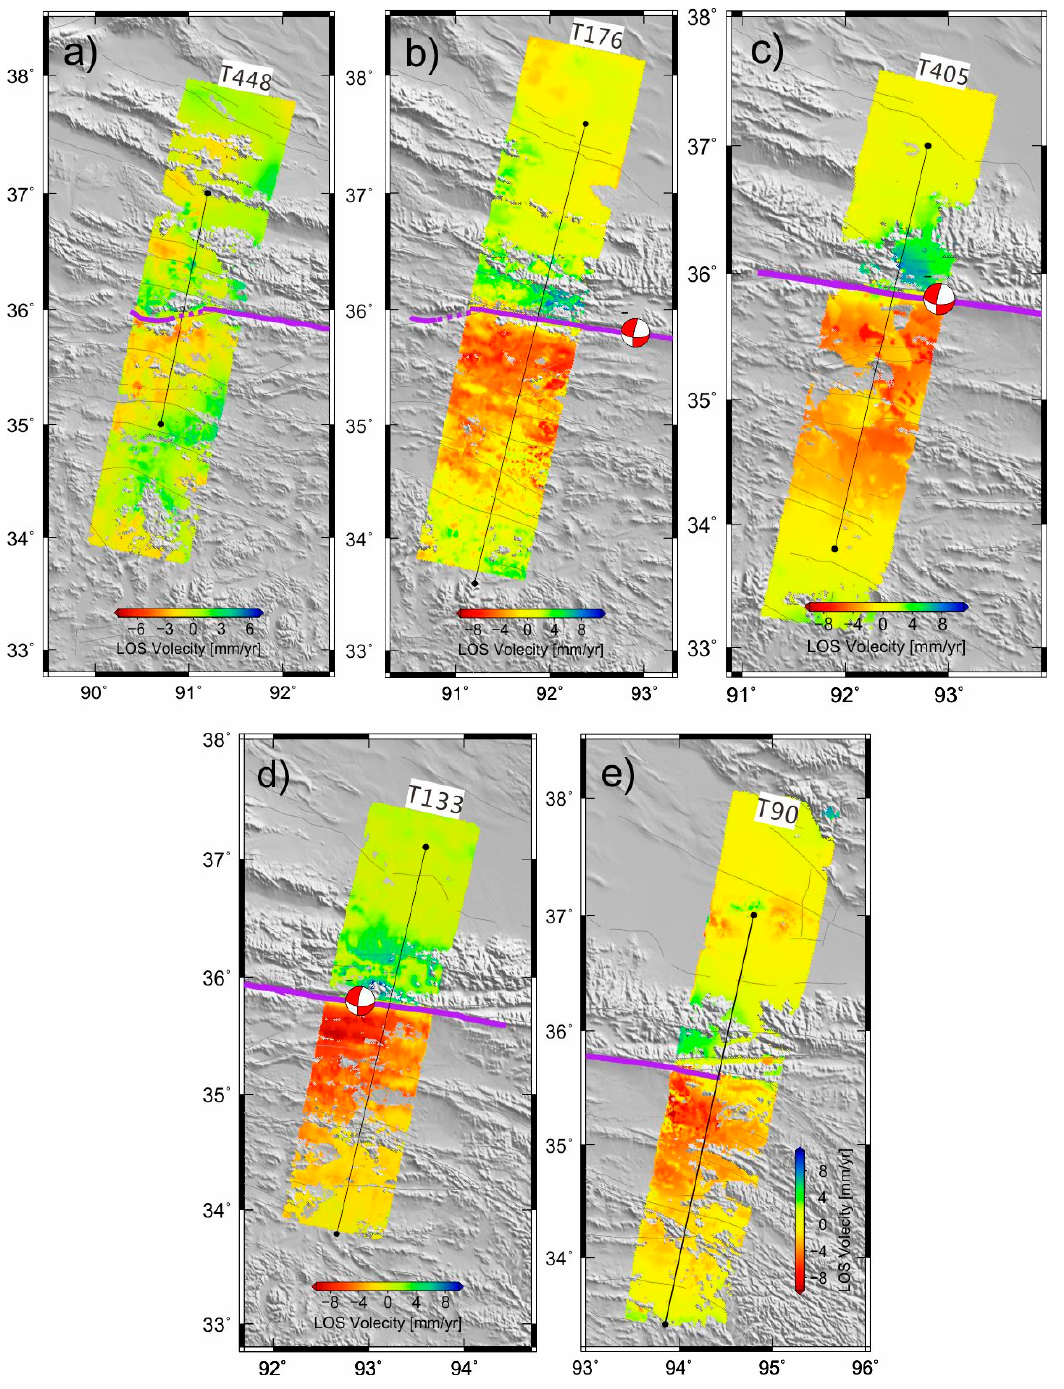
Figure 5. Line of sight (LOS) postseismic surface velocities (2003–2010) following the 2001 Kokoxili earthquake for each InSAR track, 448 ( a ), 176 ( b ), 405 ( c ), 133 ( d ) and 90 ( e ), from west to east. Fault traces, focal mechanism and surface ruptures caused by the 2001 event are as in Figure 1. The dark line in each panel is the profile location for plots in Figure 6.